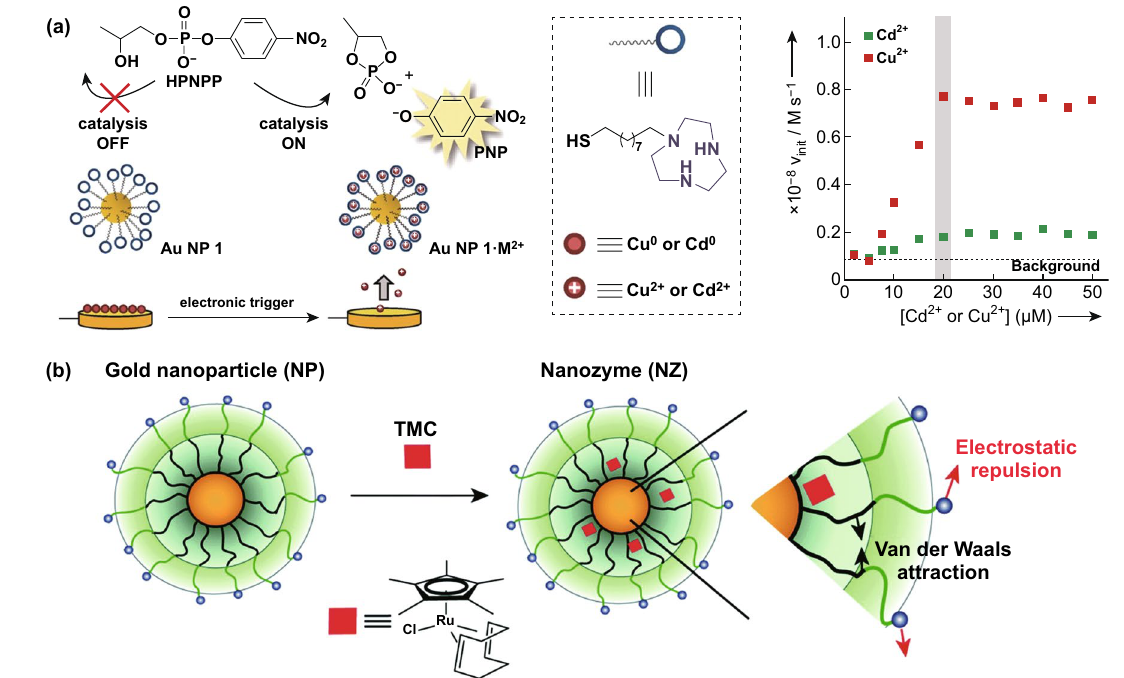
Fig. 14 Traditional nanozyme definition combining AuNPs with metallic ions used as catalysts. a Catalytic cleavage of HPNPP by Cd 2+ and Cu 2+ ions complexed by the AuNP‑bound monolayer [216]. Copyright 2016 Wiley–VCH Verlag GmbH & Co. KGaA. b Ru catalysts inserted in the protective layer of AuNPs [215]. Copyright 2017 The Royal Society of